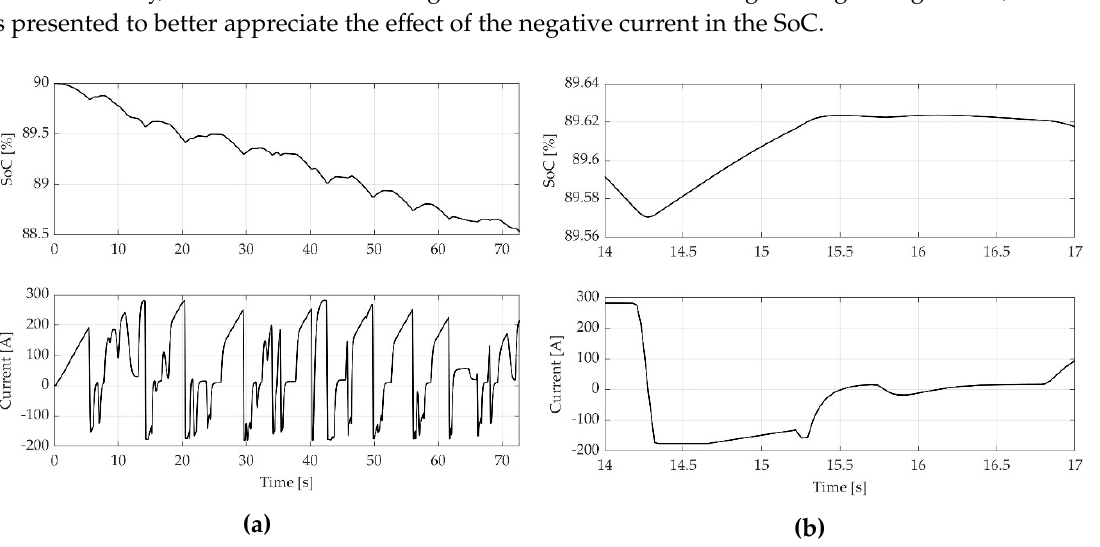
Figure 12. Braking forces and maximal forces (a) rear wheels; (b) front wheels.